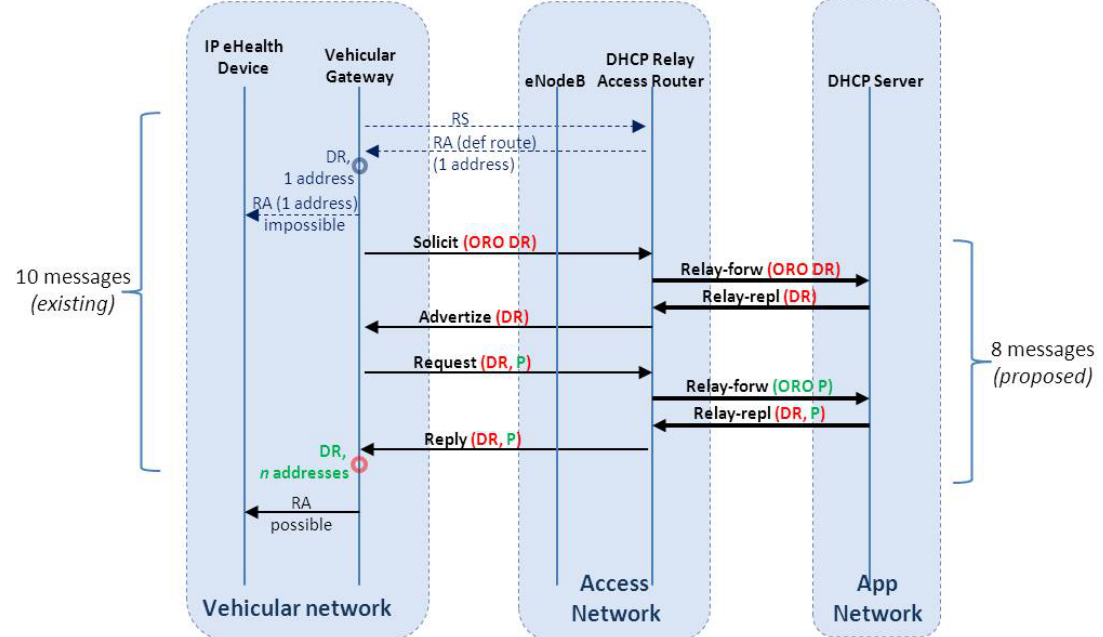
Figure 6. Auto-configuration protocol messages. A comparison of the number of messages between current auto-configuration methods and the proposed one. DR stands for Default Route, P for prefix and ORO for option request